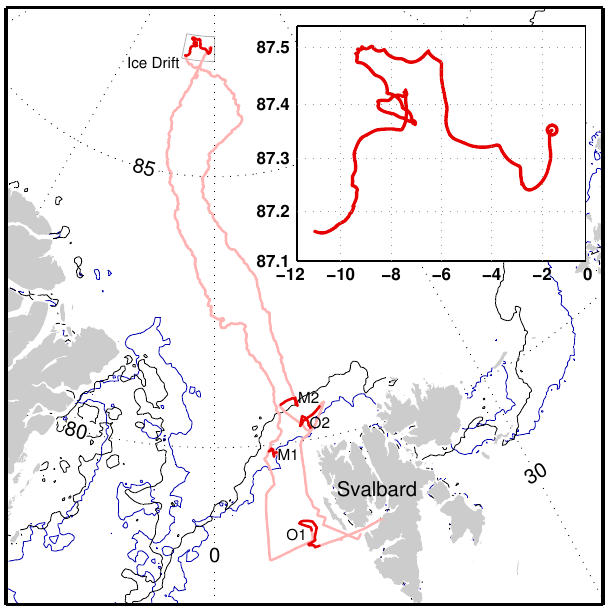
Figure 1. Map of the ASCOS route. O1 represents the open water station (named OW station in this paper), M1 the marginal ice zone station (named MIZ station in this paper), and the “ice drift” (named ice floe (IF) station in this paper). The blue and black lines describe the extent of the ice at the time of entry and exit. The inset shows details of the ice drift period. For instrument safety reasons, the ATOFMS was not measuring during the traverse between the MIZ and IF station, nor was it during the return